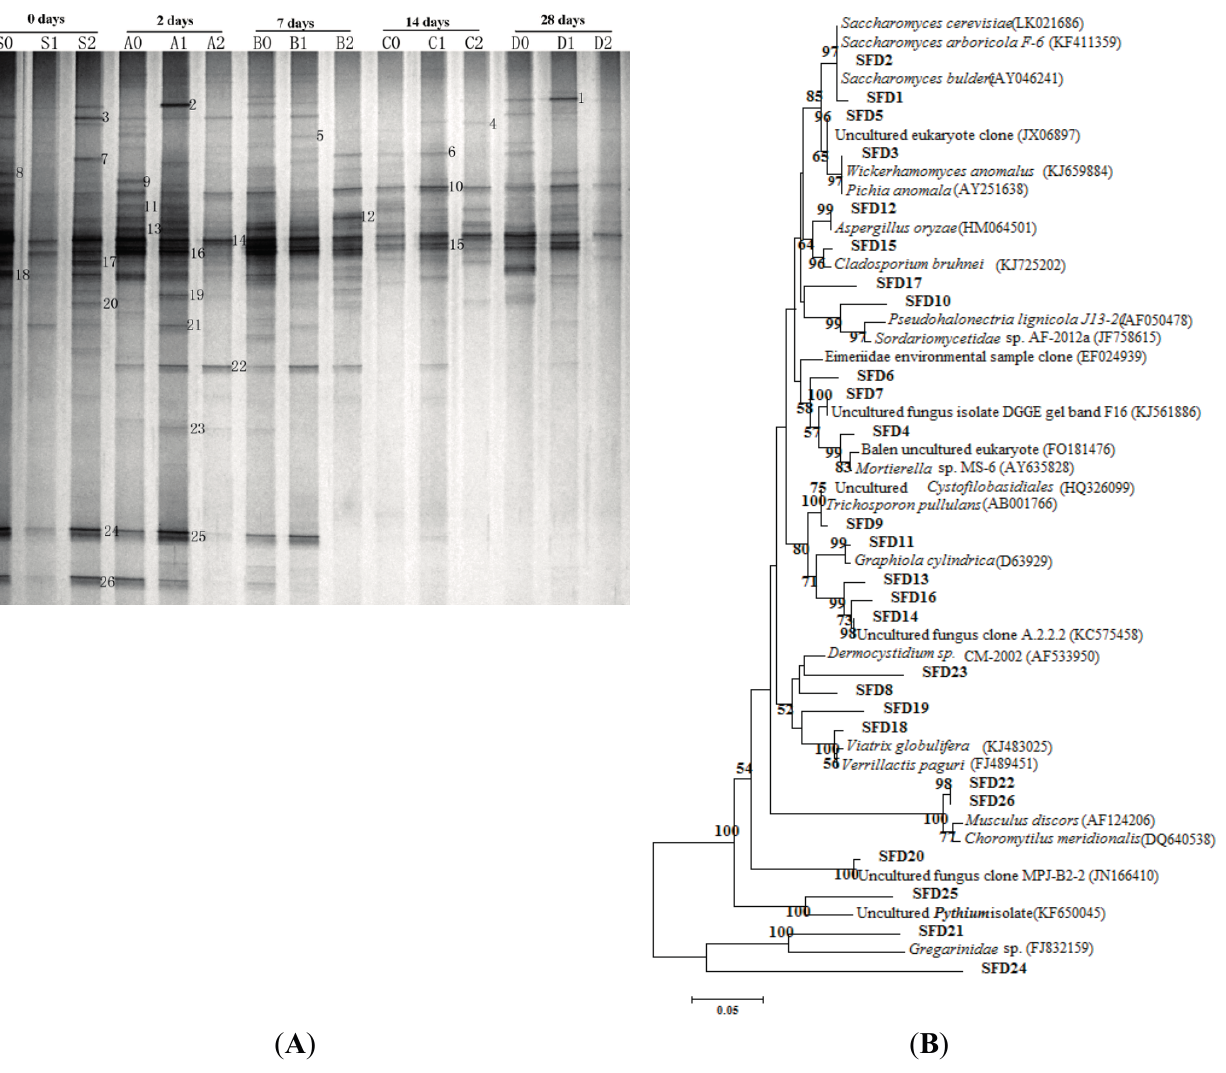
Figure 1. DGGE (denaturing gradient gel electrophoresis) profiles of sediment fungal communities exposed to different concentrations of PAH (polycyclic aromatic hydrocarbon) contamination at different incubation stages (S: Day 0; A: Day 2, B: Day 7, C: Day 14, D: Day 28; 0: control without PAH addition; 1: 100 mg/kg; 2: 1000 mg/kg) ( A ); neighbor-joining phylogenetic tree based on 18S rRNA gene sequences from DGGE bands. Bootstrap analysis was based on 1000 replicates. Bootstrap values from distance analysis are depicted. Bootstrap values less than 50% are not shown ( B